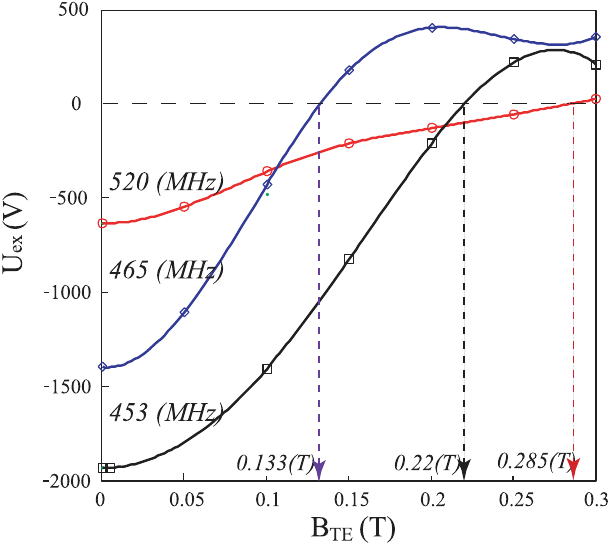
FIG. 8. (Color) Particle-dipole mode energy exchange behavior versus focusing strength of the 1013 MHz TE 021 mode ( B TE is the maximum TE magnetic field on-axis). The particles are accelerated from 2 to 6.35 MeV by the fundamental TM 010